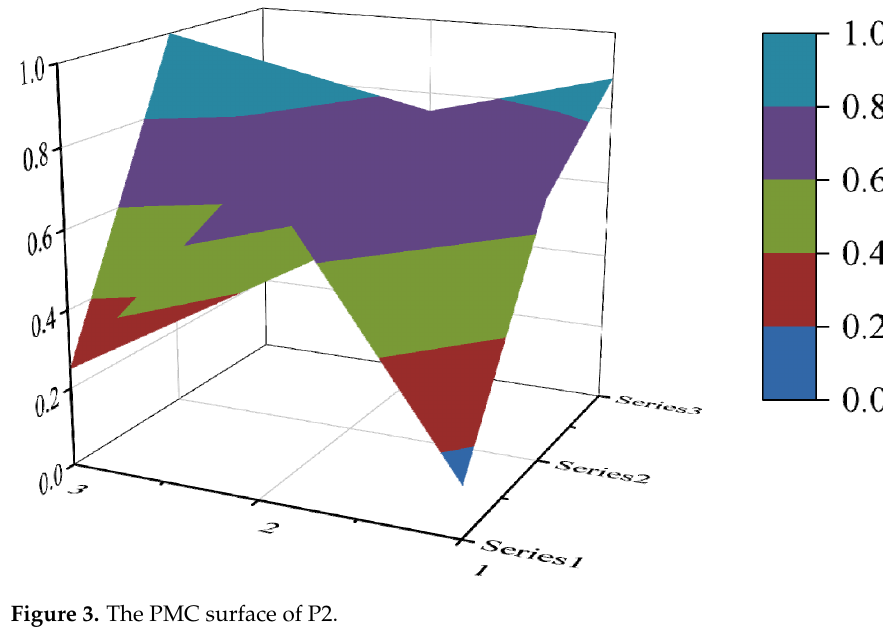
Figure 3. The PMC surface of P2.